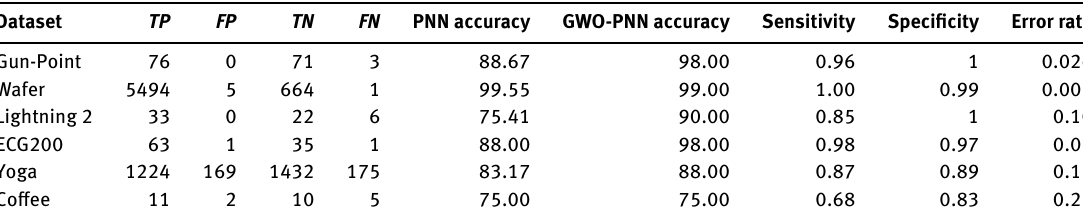
Table 4: Classification Accuracy, Sensitivity, Specificity, and Error Rate (%) of GWO-PNN. Dataset